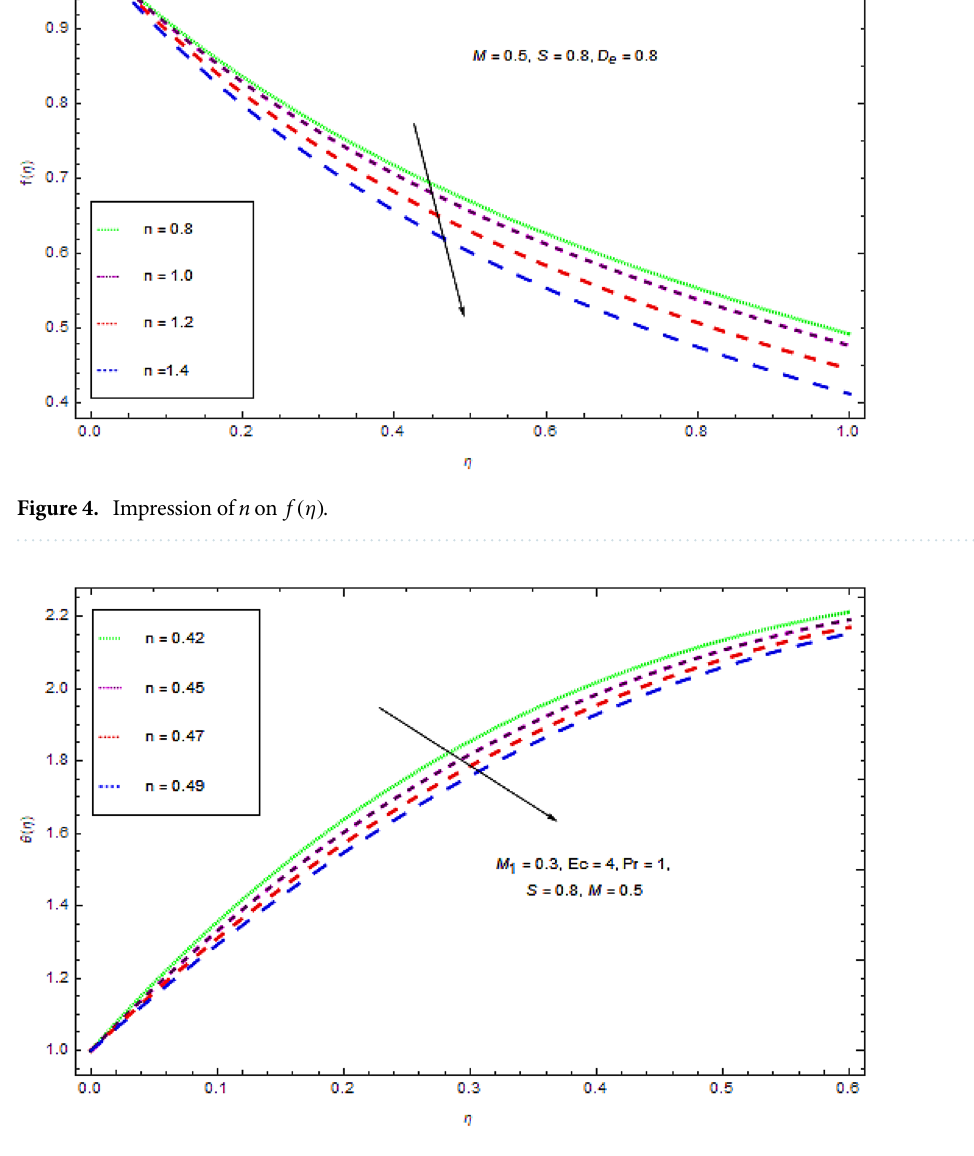
Figure 5. Effect of n on θ(η)